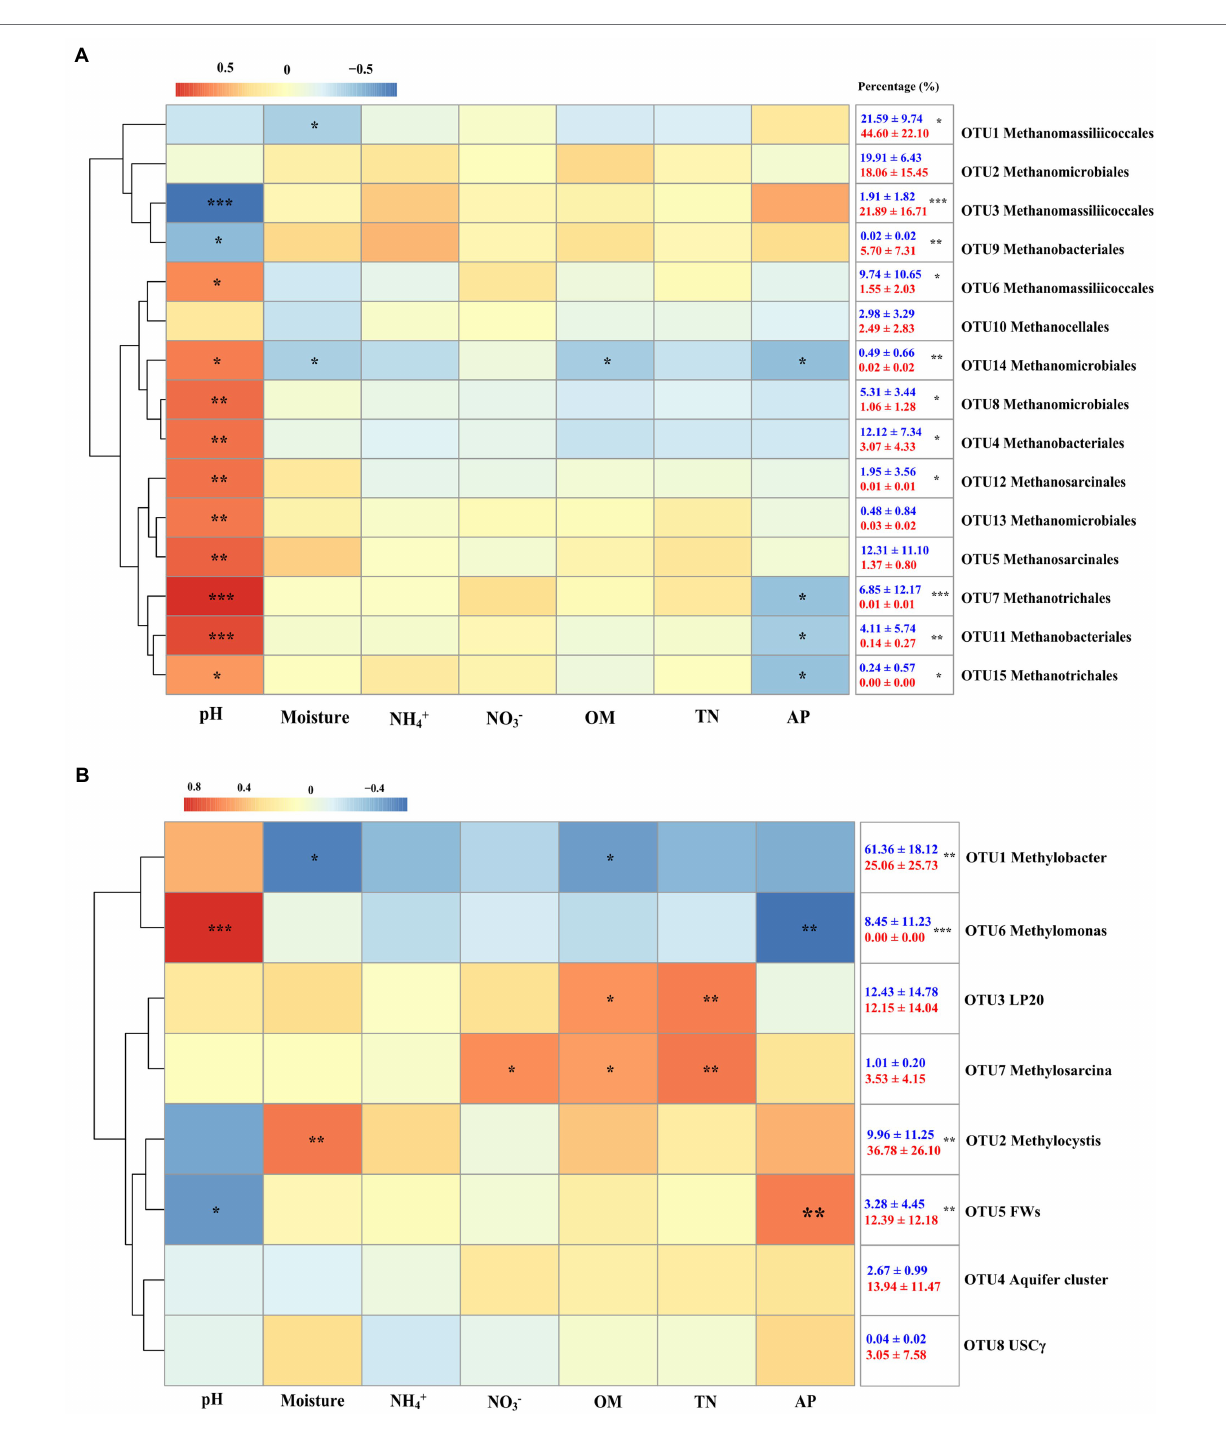
FIGURE 5 | Heatmap of Spearman correlations of the relative abundance of methanogens (A) and methanotrophs (B) with soil properties. Colors represent the rho-value of Spearman correlations between the relative abundances of taxonomic groups and soil properties. The numbers in the right indicate the relative abundance of methanogens and methanotrophs in hollow (blue) and hummock soils (red; mean ± SE). Asterisks in the box indicate significant differences in the relative abundance between hollow and hummock soils (*** p < 0.001, ** p < 0.01, and * p <